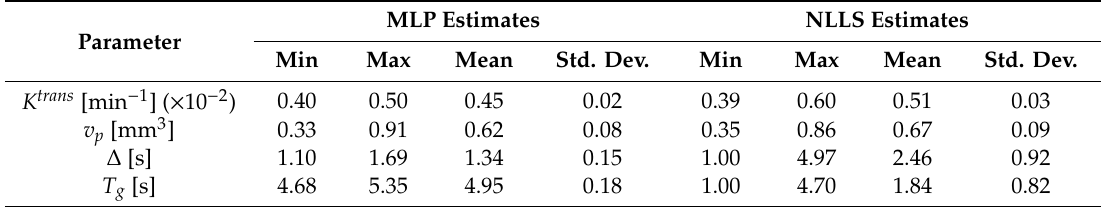
Table 3. Statistics of the estimated values of the two-compartment filtration model parameters. MLP Estimates NLLS Estimates Parameter Min Max Mean Std. Dev. Min Max Mean Std. Dev. K trans [min − 1 ] ( × 10 − 2 ) 0.40